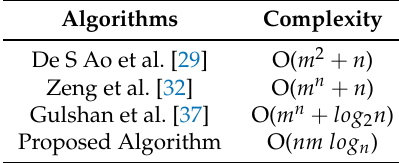
Figure 12. Residual energy comparison. Table 4. Complexity